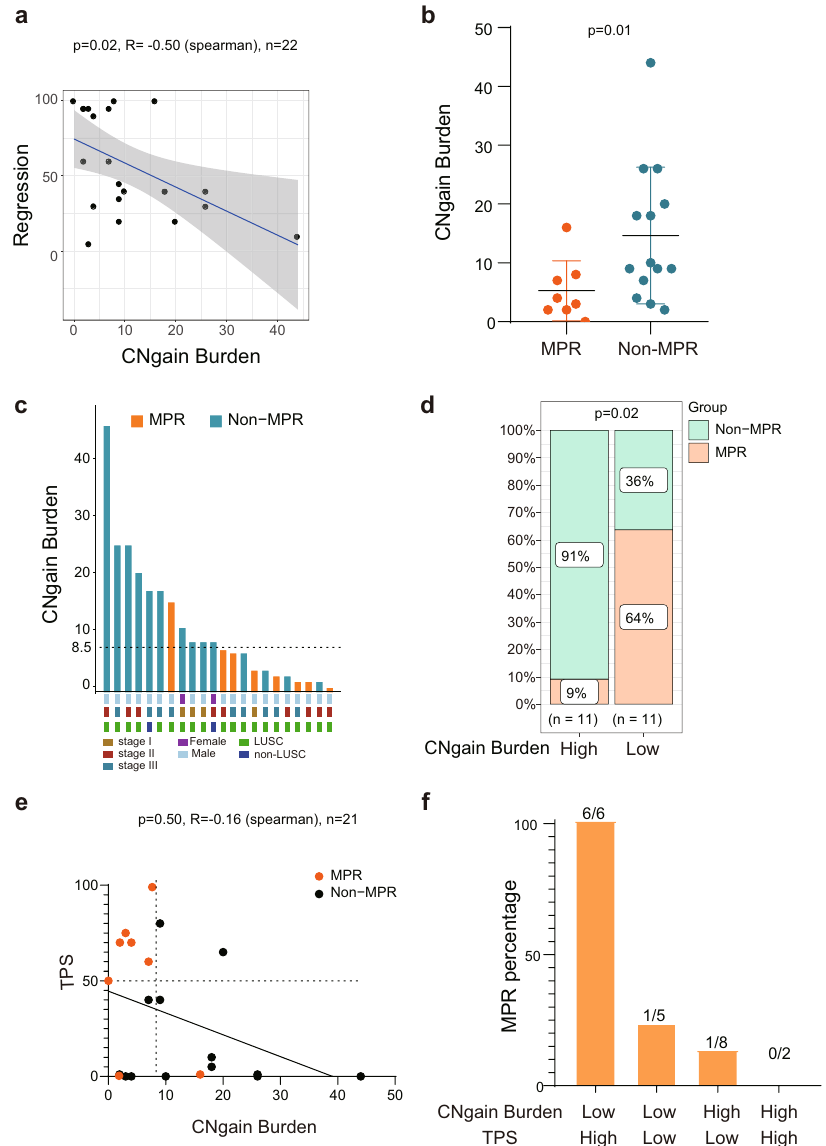
Fig. 2 CNgain burden correlates with pathologic response to sintilimab. a The correlation between pathological regression and CNgain burden (Spearman ’ s correlation coef fi cient R = − 0.50, p = 0.02). b Comparison of CNgain burden in MPR and Non-MPR group (p = 0.01, Mann – Whitney U test). c , d Distribution of MPR and Non-MPR patients in groups with high ( ≥ median) or low CNgain burden (<median) (p = 0.02, Fisher ’ s exact test). e The correlation between CNgain burden and TPS (Spearman ’ s correlation coef fi cient R = − 0.16, p = 0.50). f Rates of MPR in each of the four indicated